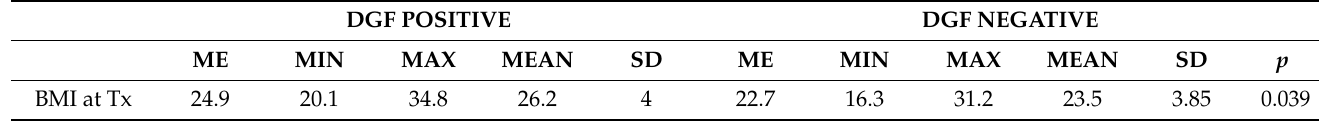
Table 2. BMI at Tx values in DGF POSITIVE and DGF NEGATIVE